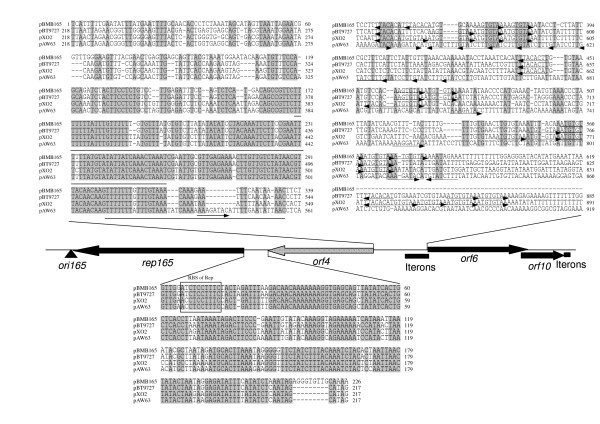
Alignment of the non-coding regions between rep and replication-associated genes of pBMB165, pBT9727, pXO2 and pAW63. The shaded letters indicate identical nucleotides. Arrows on the nucleotide sequences represent the iterons sequences. The conserved regions of high A+T content are underlined. The putative ribosome binding site (RBS) of rep is also highlighted in boldface.